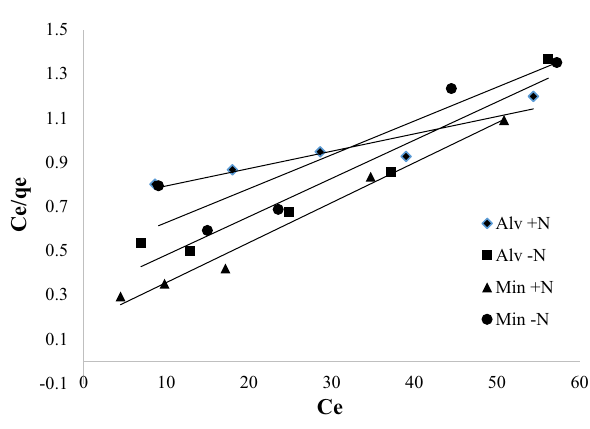
Fig. 7 Langmuir isotherm for cadmium ions onto N. alveolaris + N, N. alveolaris –N, N. minuta + N, and N/ minuta –N algae